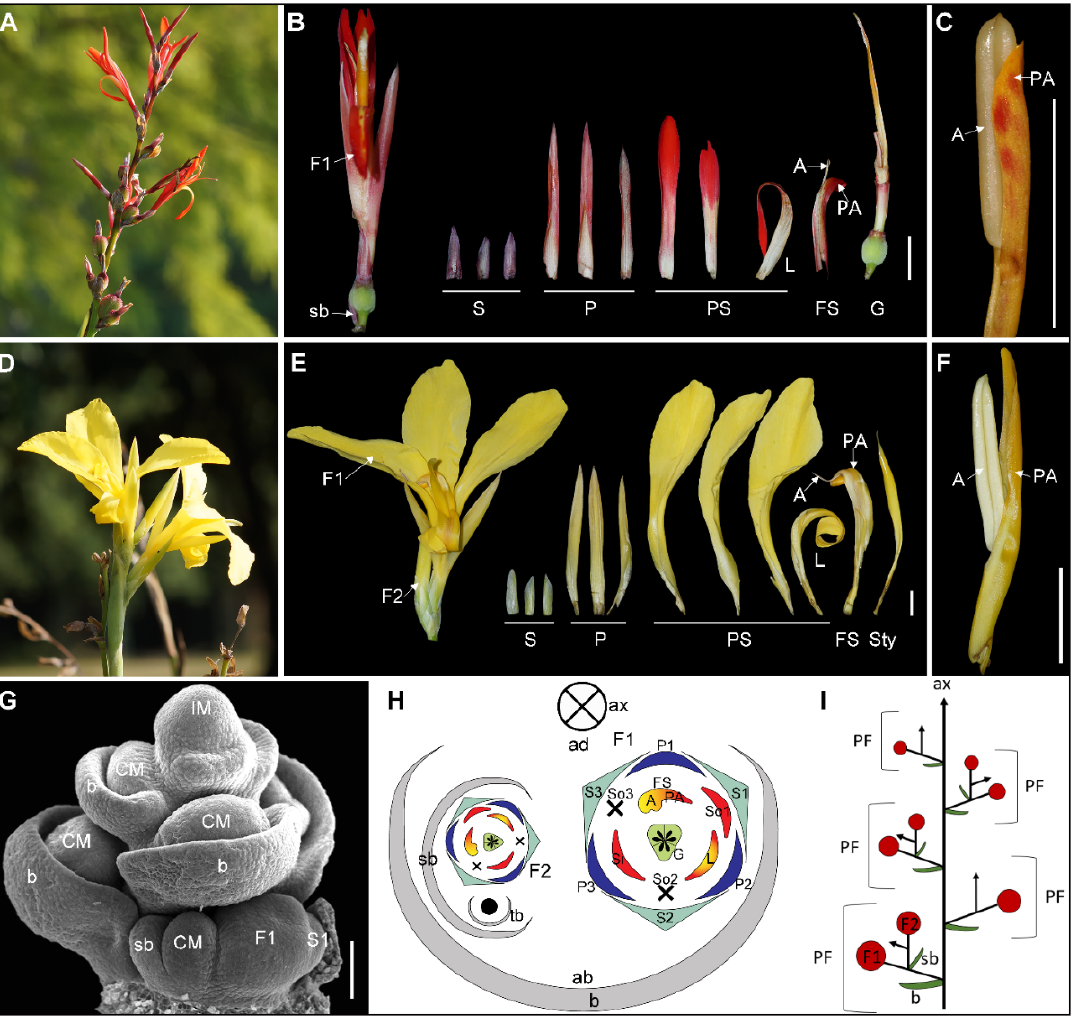
Figure 3. Normal type of inflorescence and flower in Canna . (A) to (C) C. indica . ( A ) Inflorescence of C. indica ; ( B ) 1-flowered cincinnus and flower dissection of C. indica ; ( C ) The fertile stamen of C. indica . (D) to (F) C. glauca ; ( D ) Inflorescence of C. glauca ; ( E ) 2-flowered cincinnus and flower dissection of C. glauca ; ( F ) The fertile stamen of C. glauca ; ( G ) SEM picture shows a developing inflorescence of C. indica ; ( H ) Diagram showing the ground plan of partial inflorescence of normal type Canna ; ( I ) Illustration of Canna inflorescence from lateral view. A, anther; ax, main florescence axis; b, primary bract; CM, cincinnus meristem; F1, the primary flower; F2, the secondary flower; FS, fertile stamen; G, gynoecium; IM, main inflorescence meristem; L, labellum; P, petal; P1, adaxial petal; P2, abaxial petal; P3, lateral petal; PA, petaloid appendage; PF, partial inflorescence; PS, pet- aloid staminode; S, sepal; S1, lateral sepal; S2, abaxial sepal; S3, adaxial sepal; sb, the secondary bract; Si, inner petaloid staminode; So1, lateral outer petaloid staminode; So2, aborted abaxial outer staminode; So3, aborted adaxial outer staminode; Sty, style; tb, the tertiary bract. The Bars: (B, C, E, F) = 1 cm; (G) = 100 μ m. 3.2. Morphology of the Partial Florescence and Flower Structure in Aberrant Collections The partial florescence structures among the aberrant collections are different from a typical Canna cincinnus and can be grouped into three main forms: 1. Single flower —the simplest state of a partial inflorescence which results from a reduction in the typical cin- cinnus (Figure 4); 2. Cyme —one flower formed at the first order, followed by two or three flowers to form a dichasium or a trichasium, which reverts back to monochasial at higher orders (Figures 5–8); 3. Thyrse —paired flowers subtended by conjoined primary bracts, likely representing a short raceme at the first order with each flower forming the primary flower of a cincinnus. The thyrse produces two, three, or four mature flowers in total de- pending on the length of the cincinni (Figures 9–11). The floral morphology of each col- lection (Ci-1-8, Cg-1-8; Table 1) is described according to this classification of partial inflo- rescence structures.